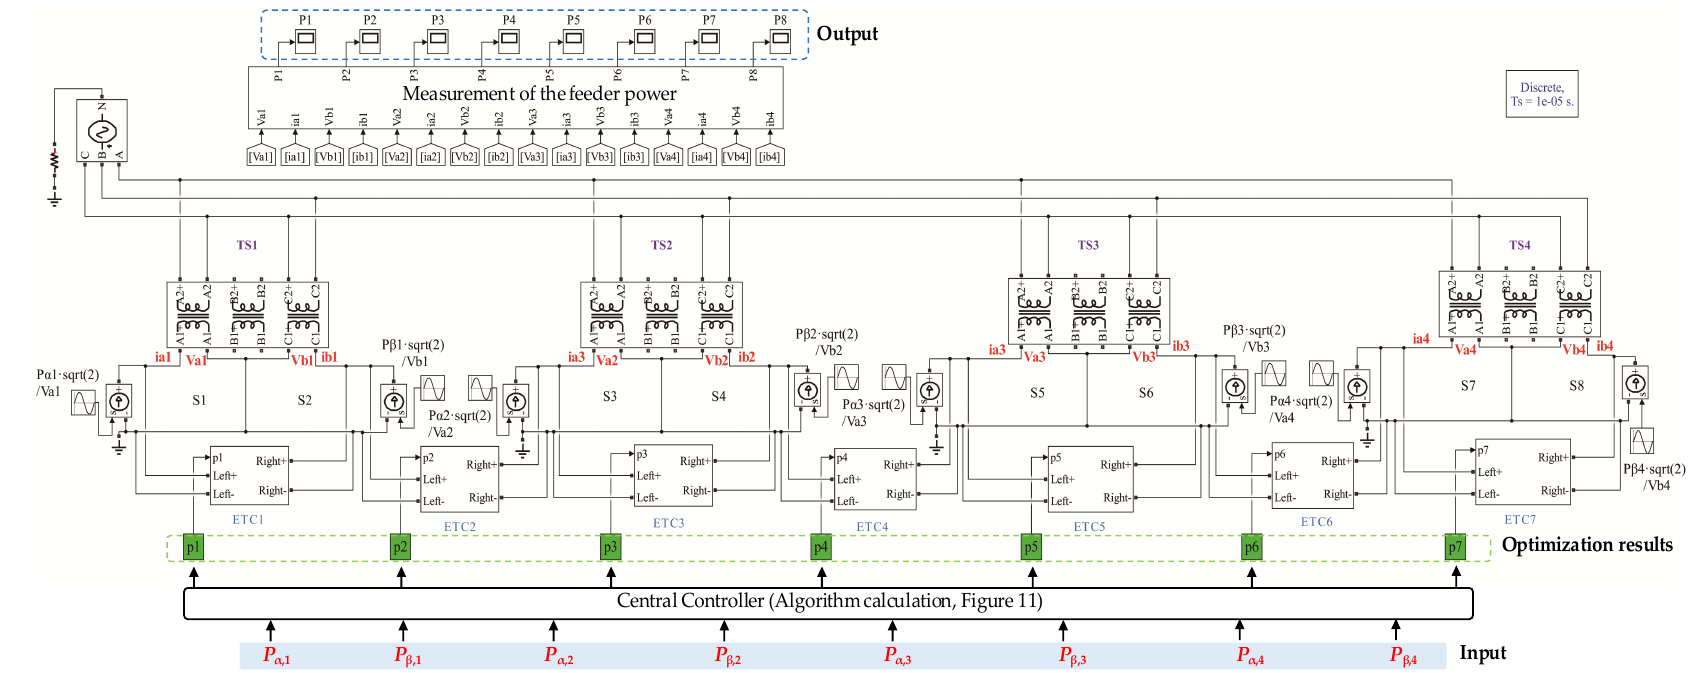
Figure 13. The Simulink model of the traction power supply system.